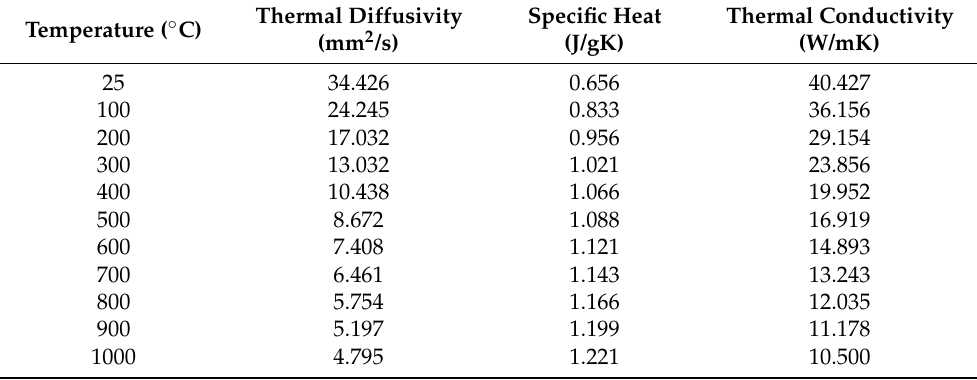
Table 10. Thermophysical properties of the aged samples obtained from slabs 21 and 24. Average values of the two